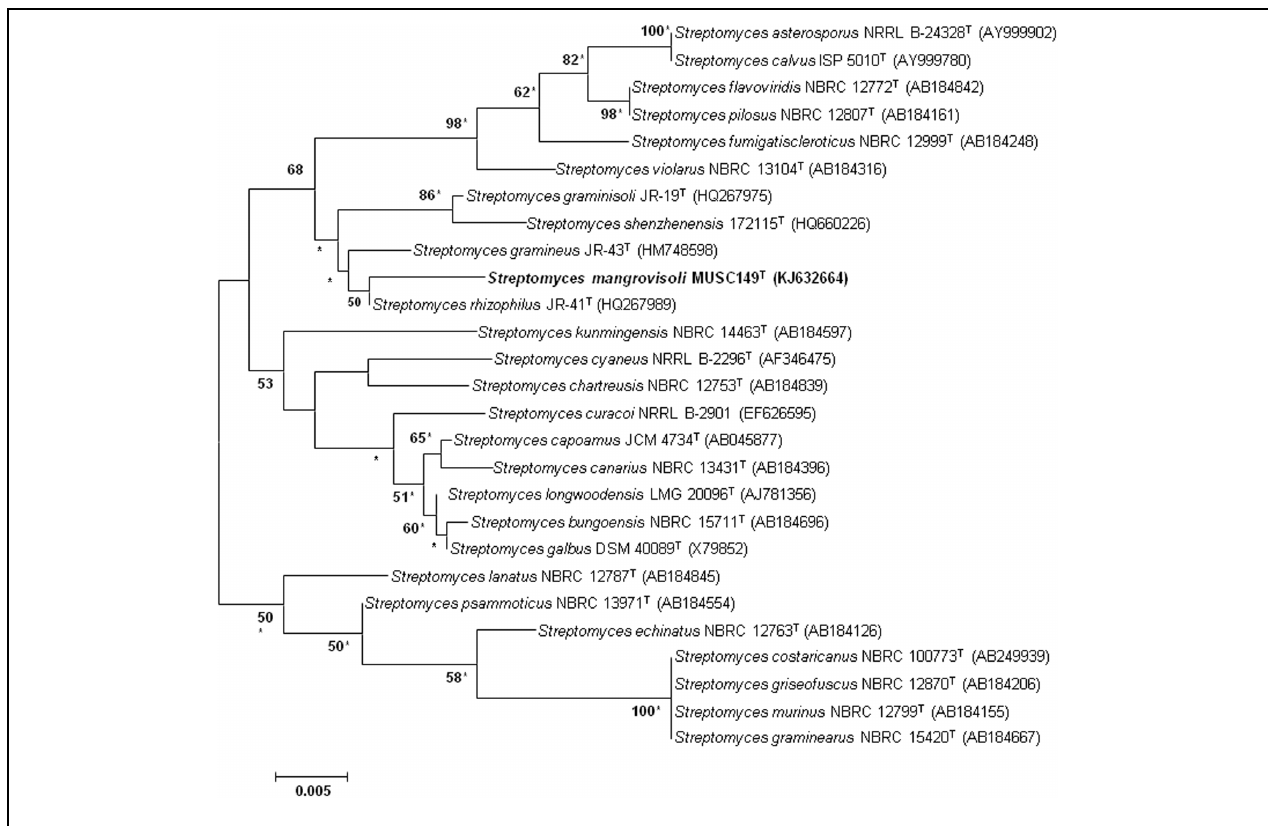
FIGURE 1 | Maximum-likelihood phylogenetic tree based on 1487 nucleotides of 16S rRNA gene sequence showing the relationship between strain MUSC 149 T and representatives of related taxa. Numbers at nodes indicate percentages of